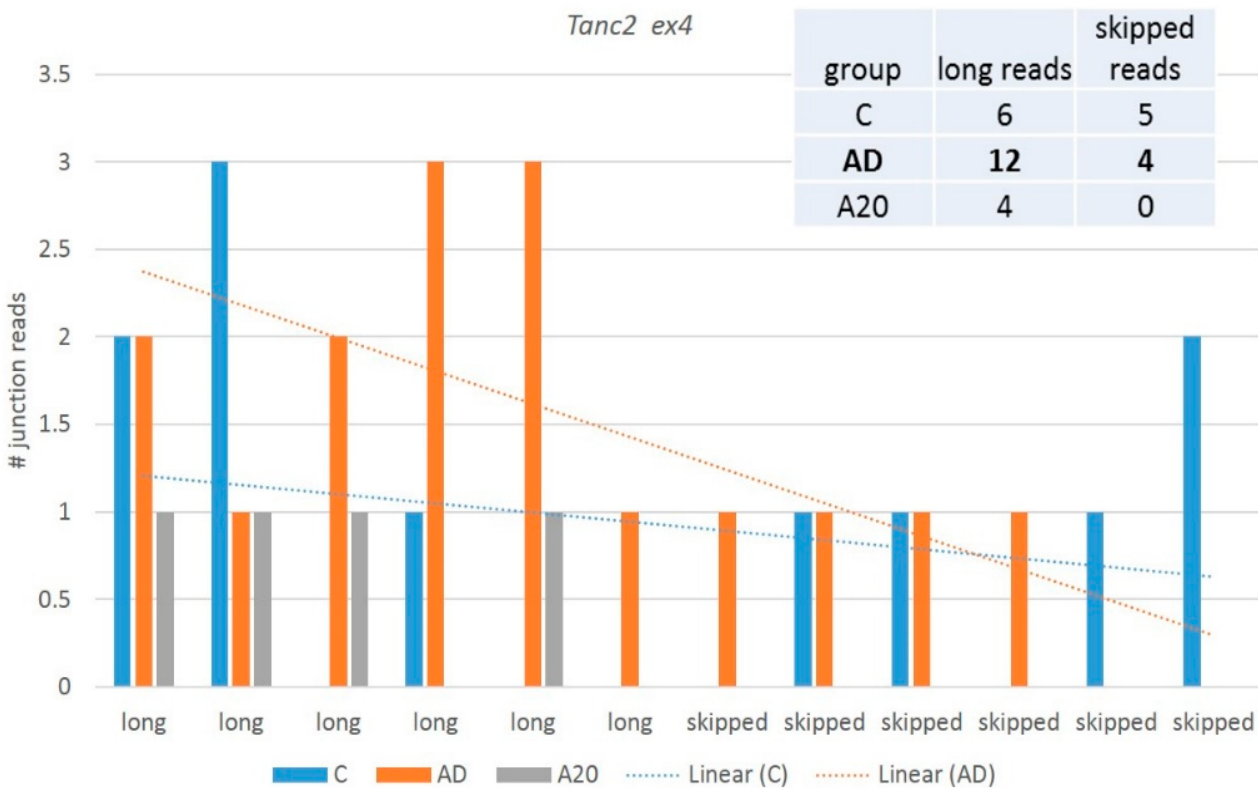
Figure 12. The AD and control groups differ significantly (FDR < 0.041) in the ratio of Tanc2 splicing patterns; in particular, the AD sample maintains the maximum number of long isoforms (12 vs. 6 reads) and similar skipped ones (four vs. five; see the embedded table). The A20 group maintains the minimum number of long reads, and none are skipped, implying the overall low expression of Tanc2 in A20.